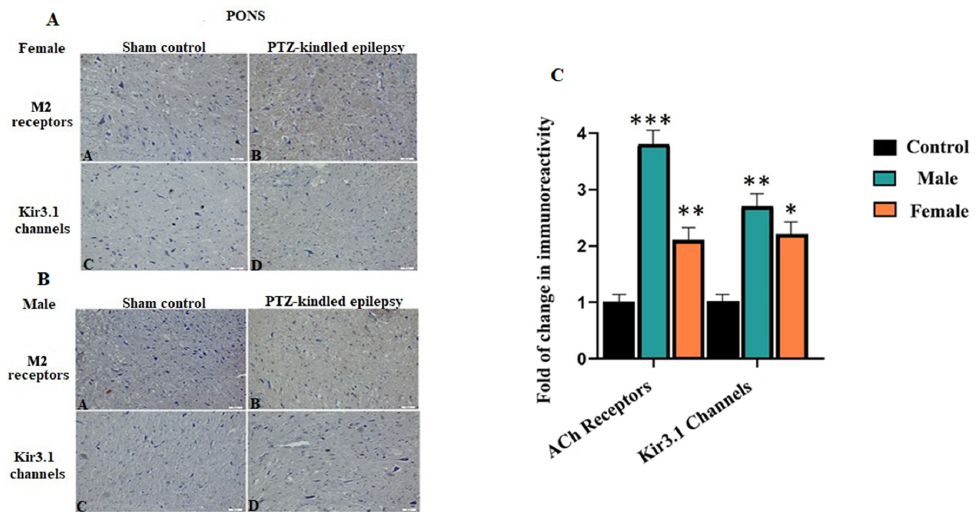
Figure 5. Examples of immunoreactivity for ACh receptors and Kir3.1 channel within the brainstem. Immunoreactivity was significantly increased for both ACh-associated centers in the represented images, the result for male rats was prepared. For female ( A ) and male ( B ) in terms of immunoreactivity at pons; A : Image of M2 receptors for control groups, B : Image of M2 receptors for PTZ-kindled of epilepsy, C : Image of Kir3.1 channels for control groups, D : Image of Kir3.1 channels of PTZ-kindled epilepsy. Pictures were taken at a magnification of × 200. Scale bar: 50 µ m. Fold change in immunoreactivity for M2 receptors and Kir3.1 channel within the brainstem ( C ). For male, PTZ-kindled rats, 3.8-fold change in the M2 receptor and 2.7-fold change in Kir3.1 channel were observed when compared to the controls. For female PTZ-kindled rats, there was a 2.1-fold change in M2 receptors and 2.2-fold change in Kir3.1 channel when compared to the controls, * p < 0.05, ** p < 0.01, *** p < 0.001.